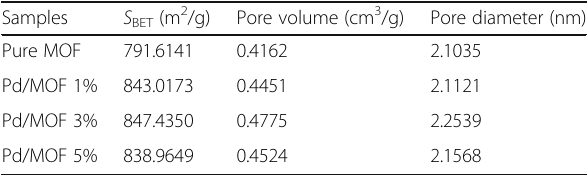
Table 1 The S BET , pore volume, and pore diameter of the four samples